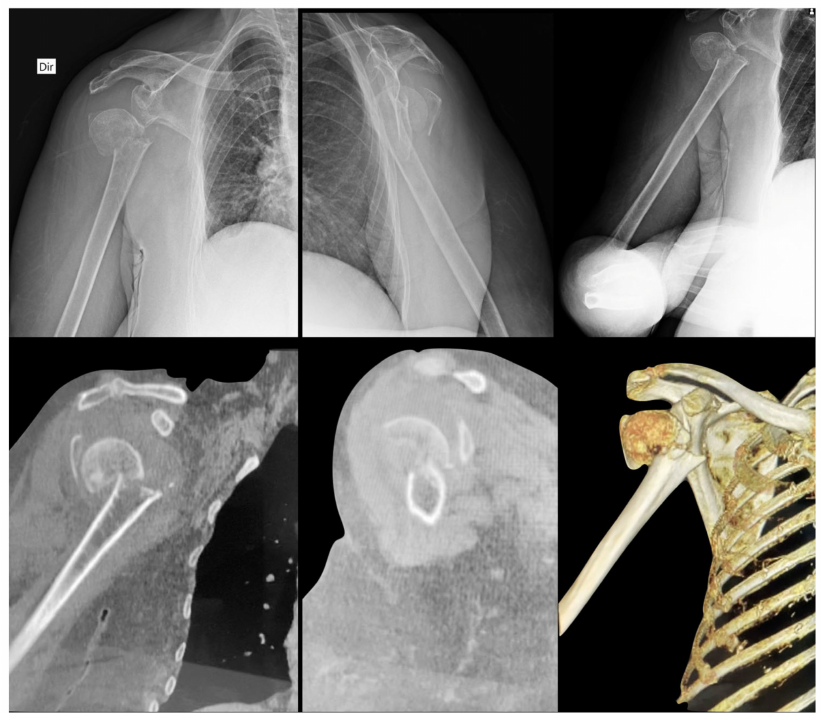
Figure 3. Radiographic and CT images of a 52-year-old female patient with a right proximal humerus fracture (Case 3). Note that the medial metaphyseal extension in the cephalic component less than 8 mm (Criterion A) and the medial metaphyseal hinge greater than 2 mm (Criterion B) are present and easily identified in both imaging exams. The fracture was classified as Neer 3-parts (head, greater tuberosity, and shaft).